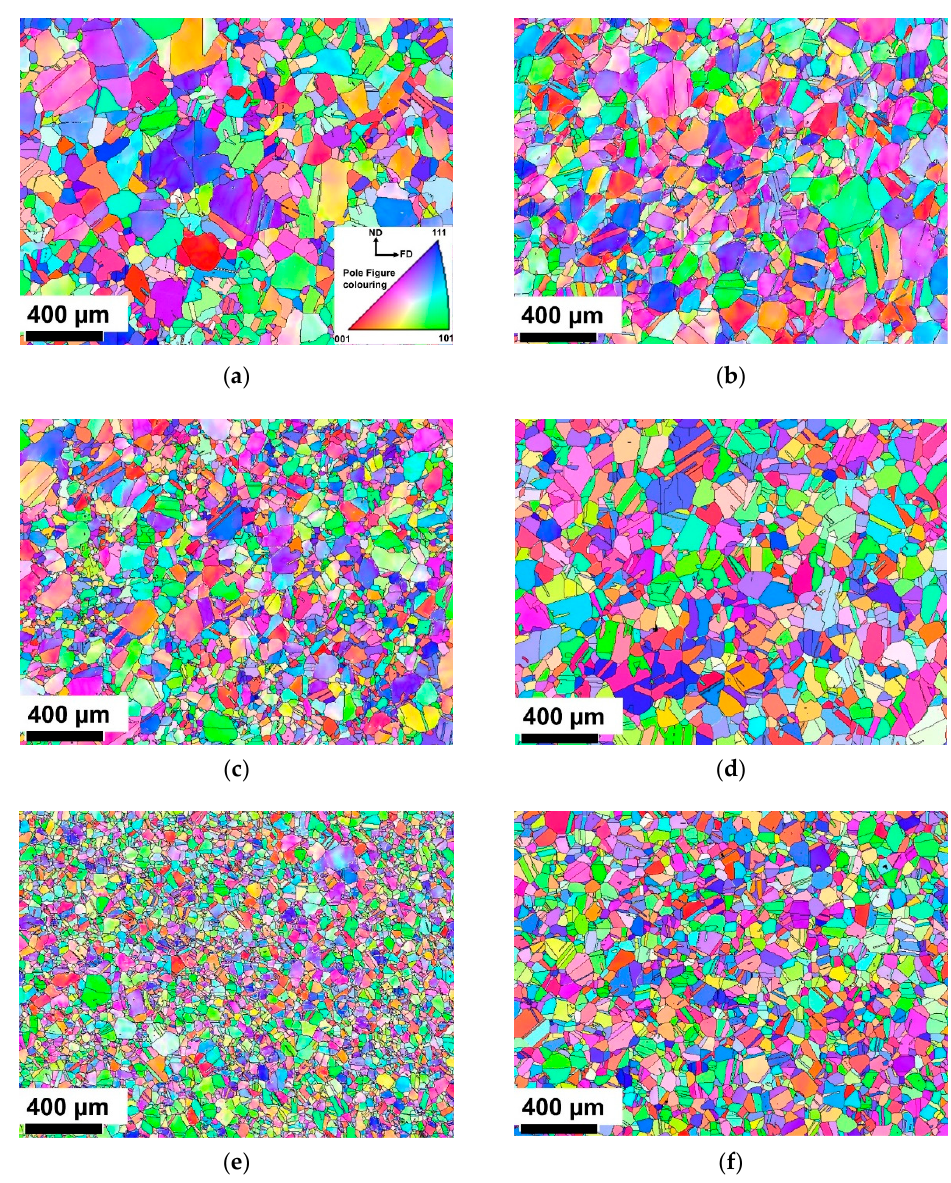
Figure 5. Inverse pole figure maps measured using EBSD showing the distribution of crystallographic directions oriented parallel to the forging axis after forging ( a , c , e ) and stabilization ( b , d , f ) in ( a , b ) sample A, ( c , d ) sample B, and ( e , f ) sample C. Typical microstructures in Alloy 825 subjected to hot-forging at different strain levels and subsequent annealing for 1 min per millimeter of rod radius at 950 °C. Table 6. Mean grain size in as-stabilized samples, including the standard deviation of the meas- urements. Table 8. The room temperature mechanical properties of as-stabilized samples, together with the minimum mechanical property requirements according to the relevant industry standard